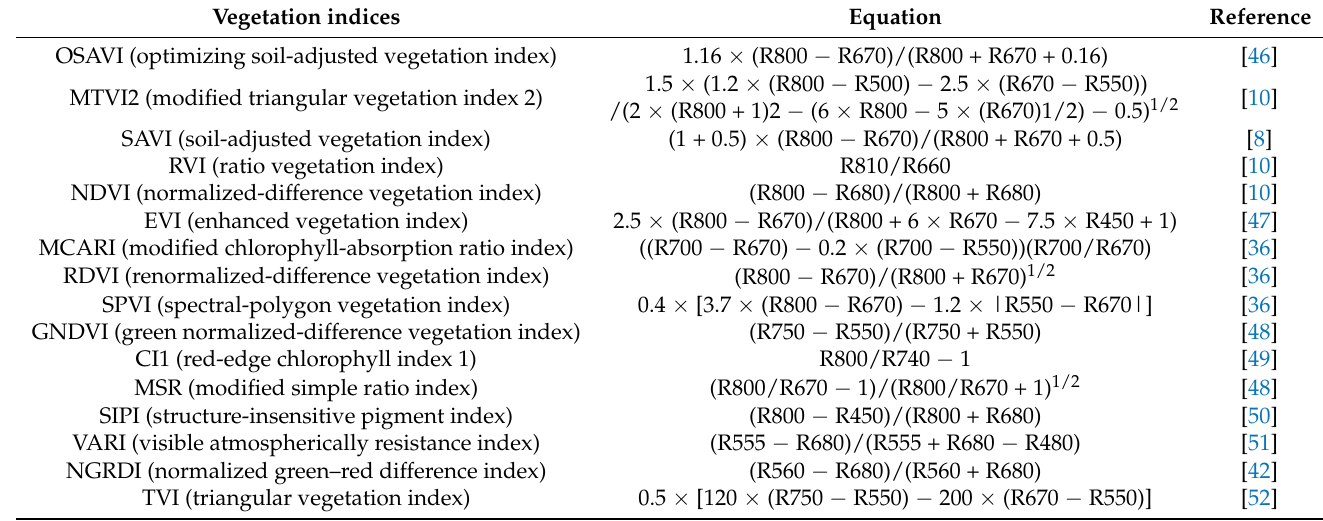
Table 1. Vis used in this